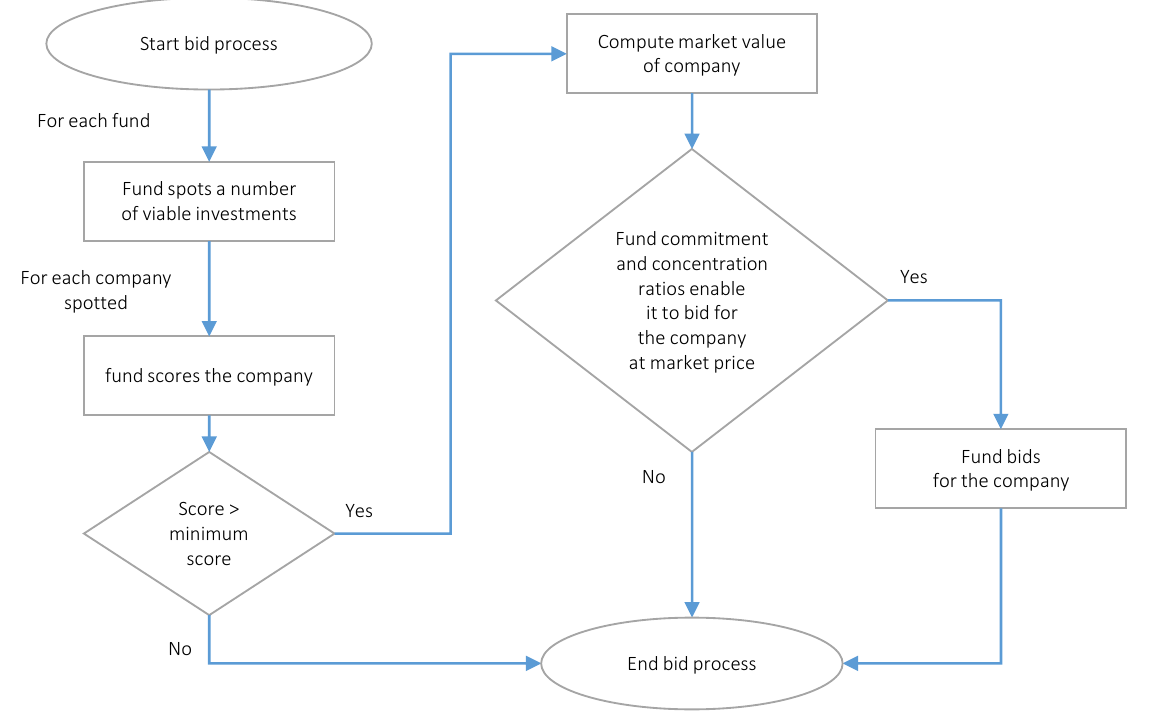
Figure 5. Flow chart of the bidding